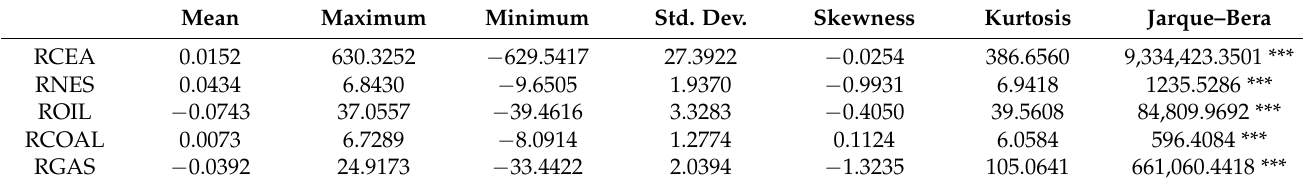
Table 2. Descriptive statistics for RCEA, RNES, ROIL, RCOAL, and